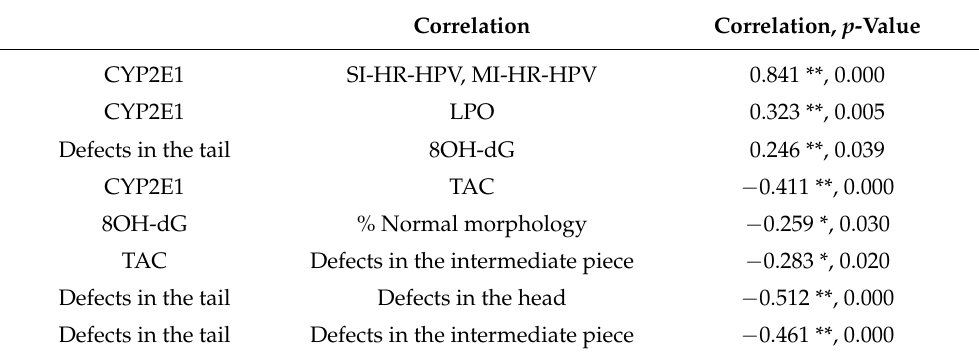
Table 4. Spearman correlation analysis between OS biomarkers in seminal plasma with sperm morphology and defects in the infected population ( n = 81/81, SI-HPV, MI-HPV).